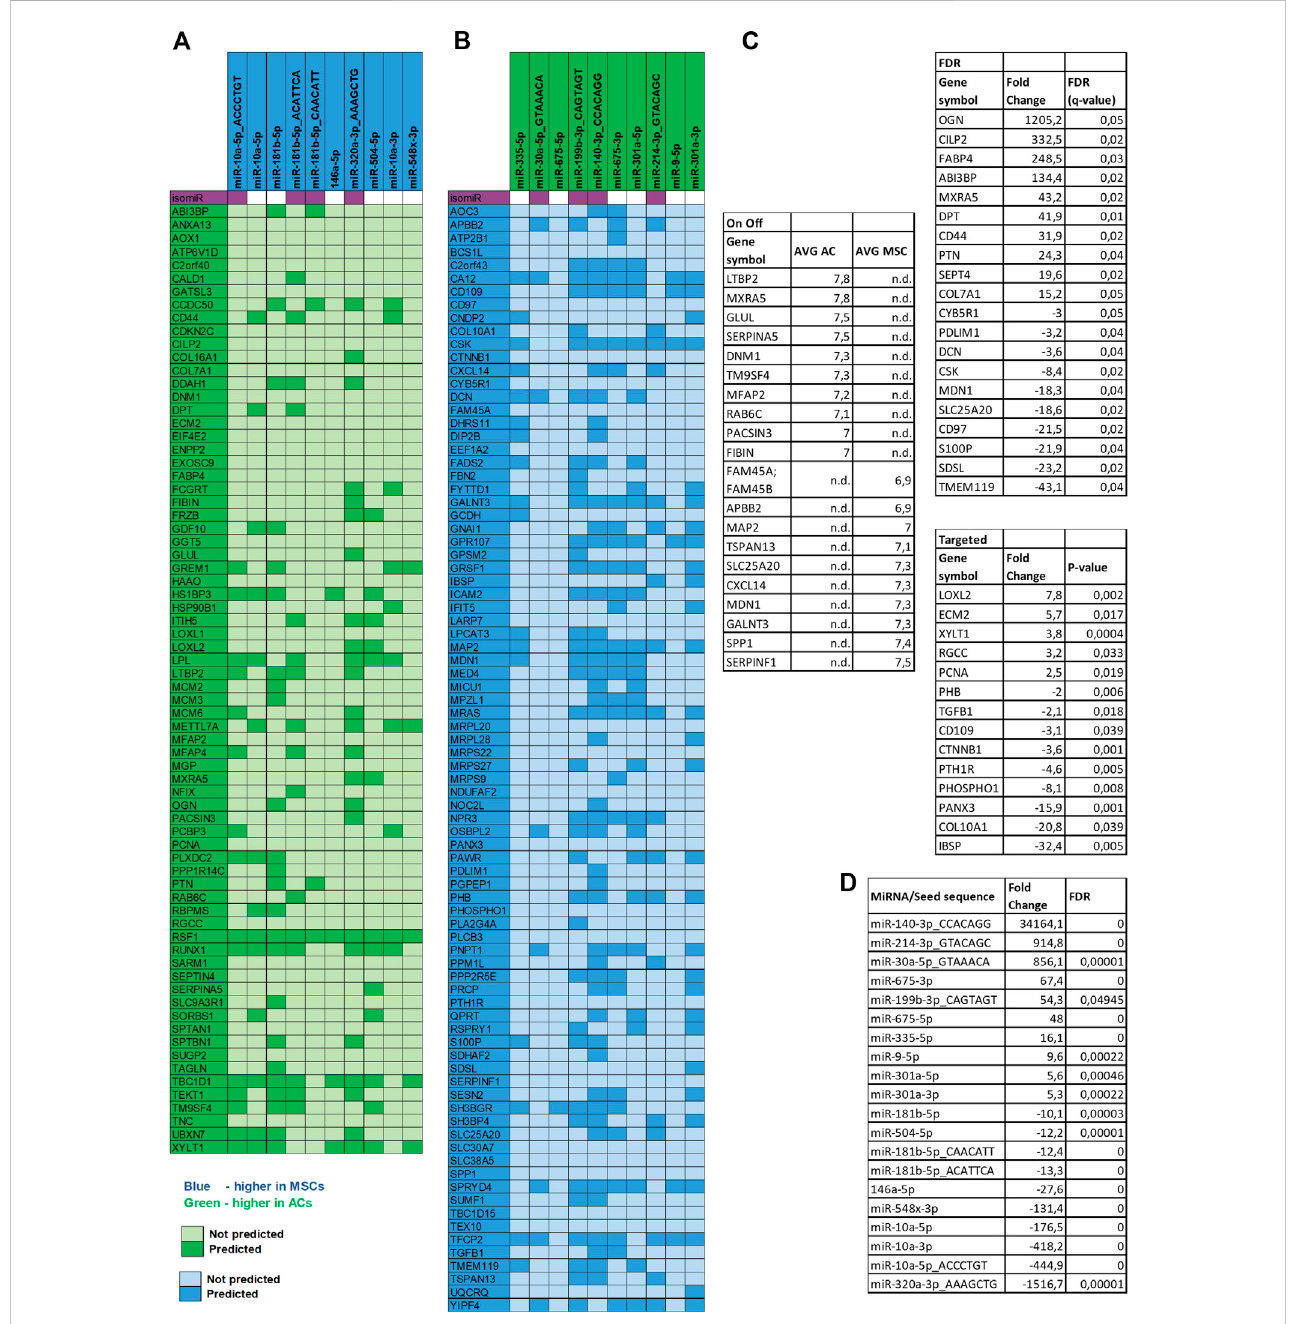
FIGURE 7 miRNA target analysis. Target mRNA prediction for the top 10 differentially expressed miRNAs in both disc types. (A) MiRNAs upregulated in MSCs and proteins downregulated in MSC discs. (B) miRNAs upregulated in ACs and proteins downregulated in AC discs. Note: Gene names are used in the fi gure instead of protein symbols. (C) Top 10 DE proteins in AC and in MSC discs of the different approaches of proteomic data analysis are presented. Note: six overlapping proteins of the On Off-list were replaced with the next ranking protein. (D) Top 10 DE miRNAs in AC and in MSC discs are